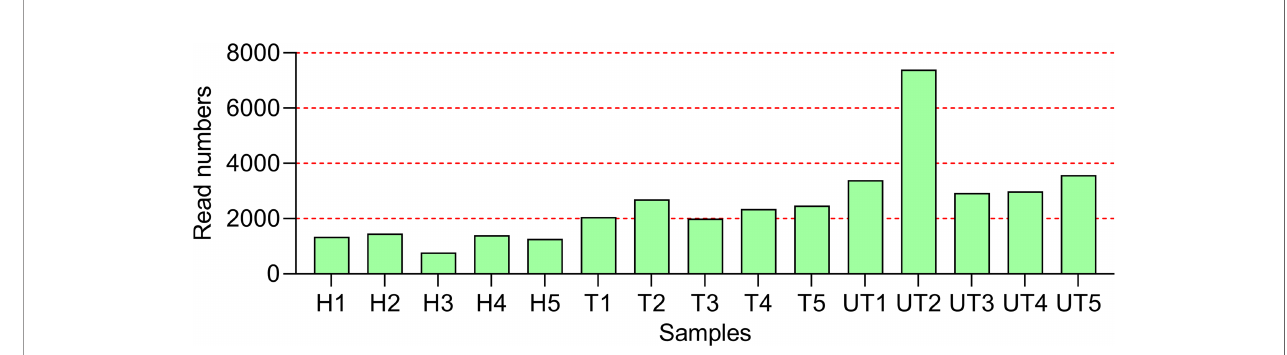
FIGURE 1 | Overall characteristics of Roche 454 sequencing in the oral fl ora in HIV-infected/AIDS patients after HAART. The statistics of Read Number for each sample. H, Normal control; UT, HIV-infected/AIDS patients not processed with HAART; T, HIV-infected/AIDS patients processed with HAART.